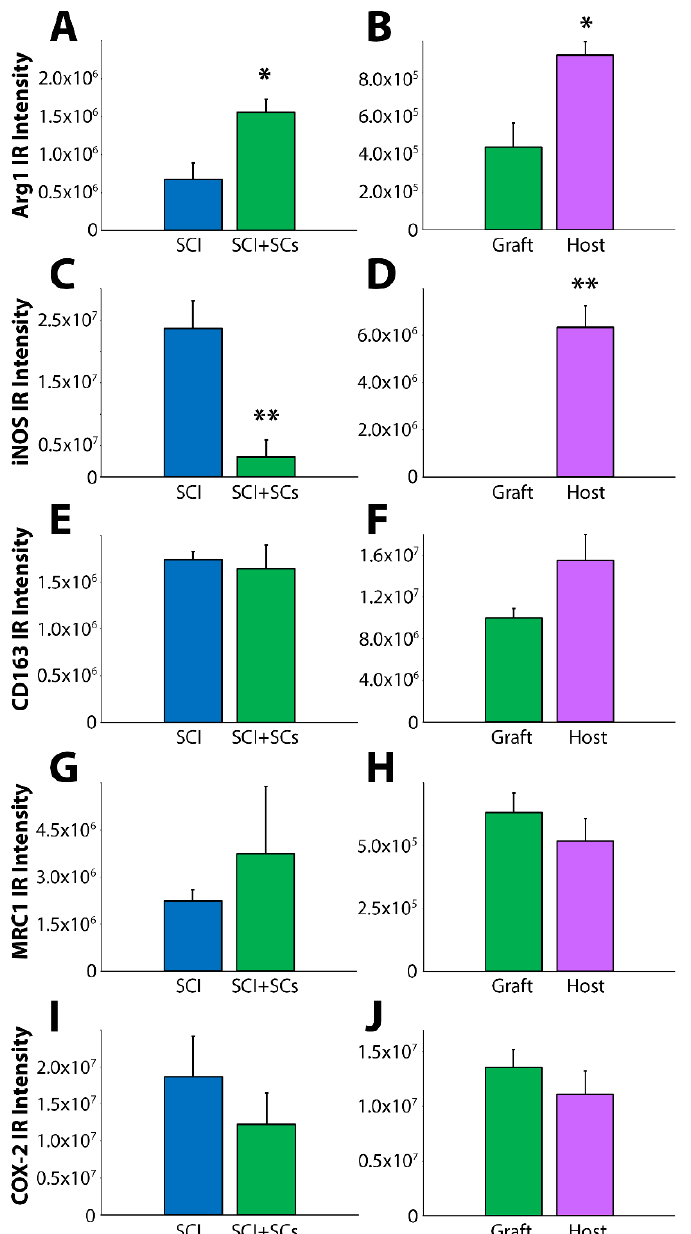
Figure 6. Immunohistochemistry revealed a significant pro- to anti-inflammatory switch in staining from iNOS to Arg1 within the injured spinal cord of SC-transplanted animals. The presence of pro- and anti-inflammatory markers of immune cell phenotype was measured quantitatively within the lesion and adjacent host spinal tissue by immunohistochemistry with specific fluorescent-conjugated antibodies and subsequent measurement of fluorescent intensity. Arg1 immunoreactive intensity was significantly increased following EGFP-SC transplantation ( A ) and this enhancement was most evident in the adjacent host tissue ( B ). In contrast, iNOS immunoreactivity was dramatically attenuated following EGFP-SC transplantation ( C ) and was virtually absent from the lesion–SC implant ( D ). EGFP-SC transplantation was not accompanied by changes in immunoreactivity for the others markers examined; CD163 ( E , F ), mannose receptor C-type 1 (MRC1; ( G , H )) and cyclooxygenase-2 (COX-2; ( I , J )). Results expressed as mean ± SEM. Statistical significance indicated at * p < 0.05 and ** p < 0.01 compared with SCI controls.